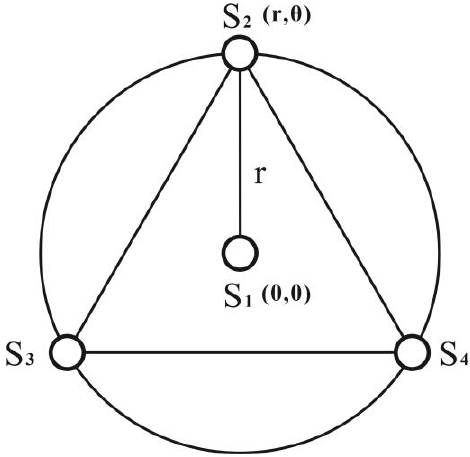
Figure 1. Illustration of the single-circle observation array for the SPAC method.